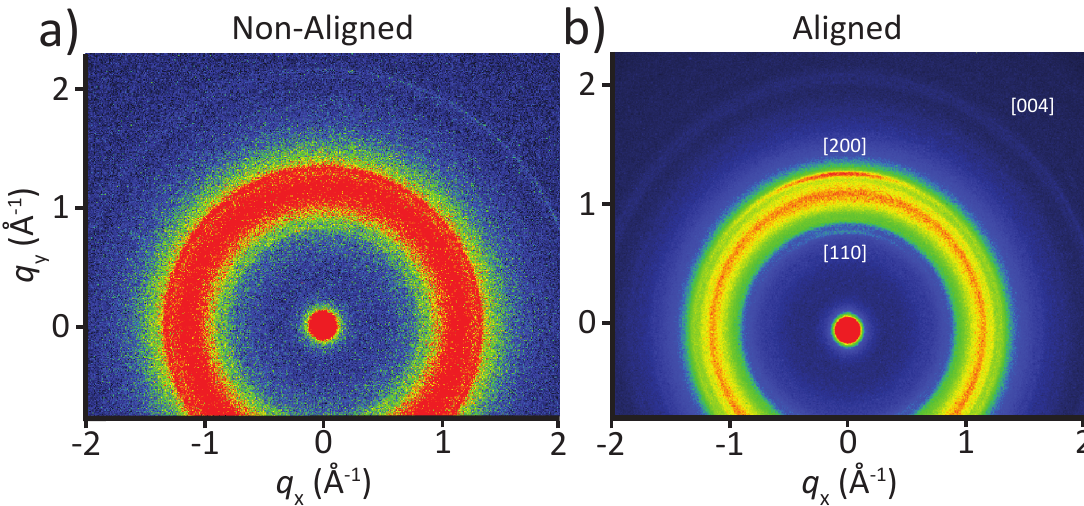
Figure 6. ( a ) 2D WAXS pattern of a 10 wt% P-tCNC nanocomposite electrospun fibrous PU/P-tCNC mat with non-aligned fibers, showing isotropic scattering as indicated by the presence of a continuous ring of uniform intensity. ( b ) 2D WAXS pattern of a 10 wt% P-tCNC nanocomposite electrospun fibrous PU/P-tCNC mat with aligned fibers showing an anisotropic intensity distribution for the [200] as well as (less visible) [110] and [004] peaks of